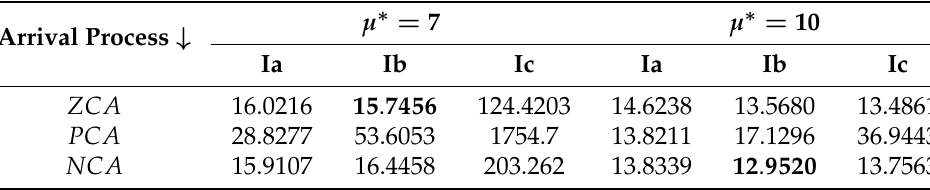
Table 14. Cost per unit time in Scenario I.